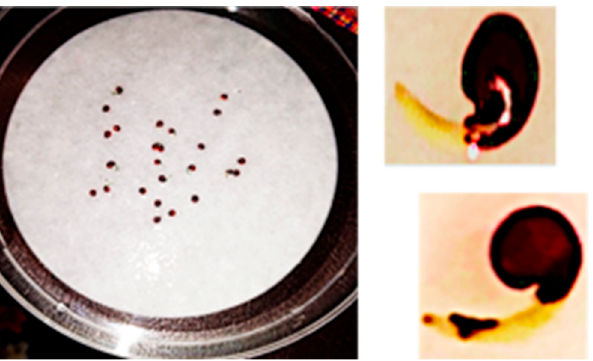
Figure 3. Appearance of the radicle of S. edulis (Flores Olvera & Noguez) germinated with 25 mg L − 1 of gibberellins at 48 h.